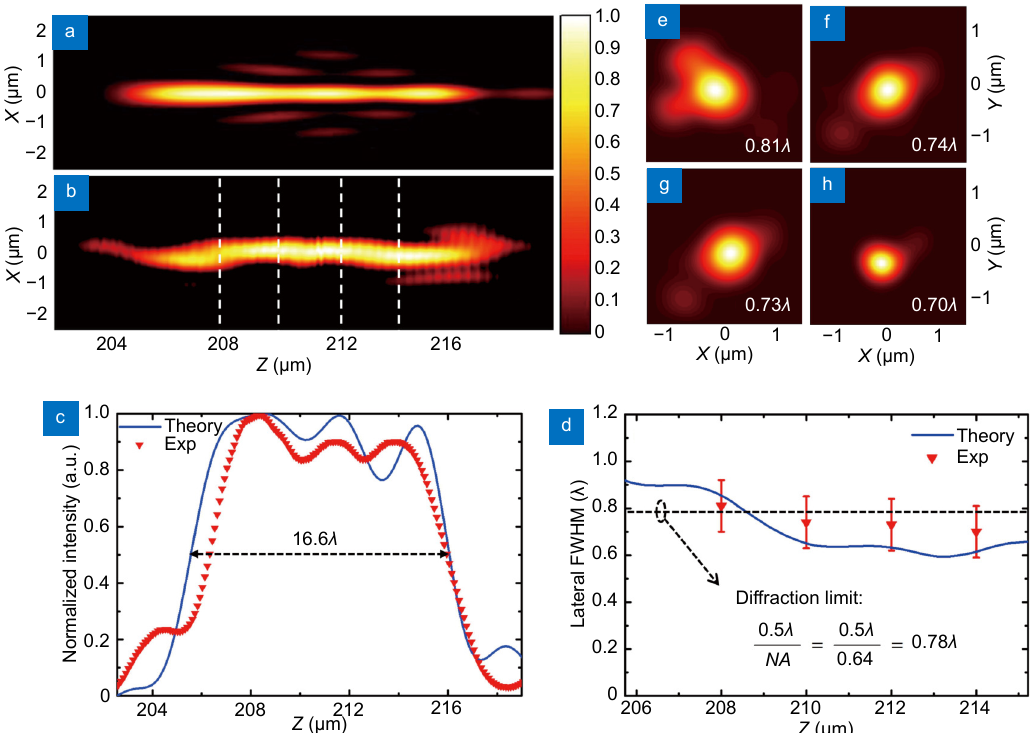
Fig. 3 | Focusing characterization of optical needle GO metalens. ( a ), ( b ) Normalized intensity distributions in the x-z plane from theoretical calculation and experiment, respectively. ( c ) Theoretical and experimental normalized intensity plots along optical axial in the focal region. ( d ) Theoretical lateral FWHM plot along z -direction near focal region and experimental FWHM points at the positions marked by the dash lines shown in (b) at 208 μm, 210 μm, 212 μm, 214 μm respectively. ( e )−( h ) Normalized intensity distributions at corresponding positions shown in (d), the lateral FWHMs at these positions are 0.81 λ , 0.74 λ , 0.73 λ , 0.70 λ